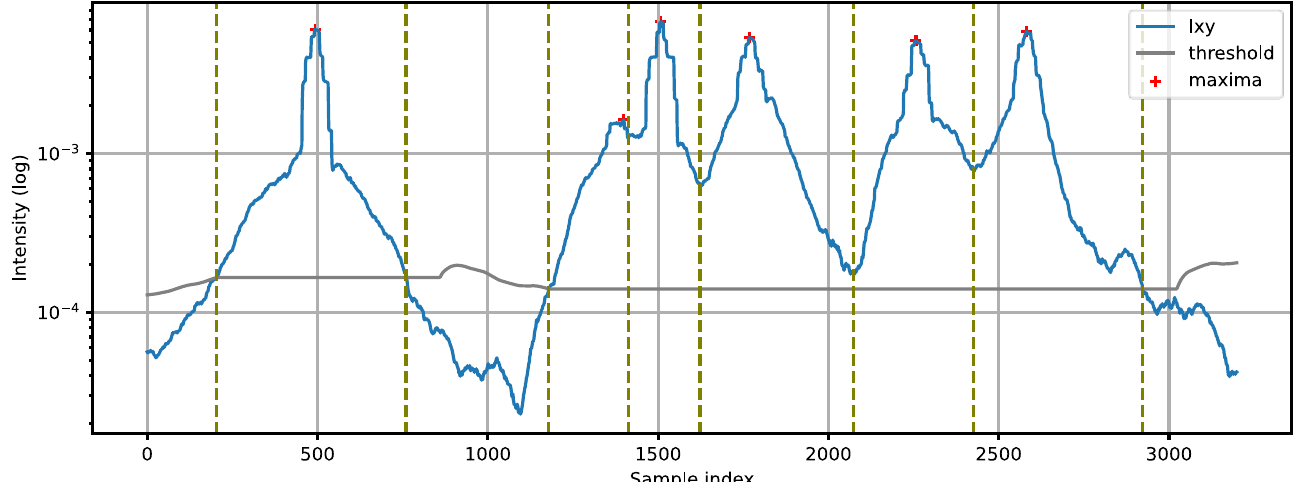
Figure 4. Example of acoustic event detection: a single vehicle followed by a group of five vehicles. Vertical dashed lines show the edges of the detected events.